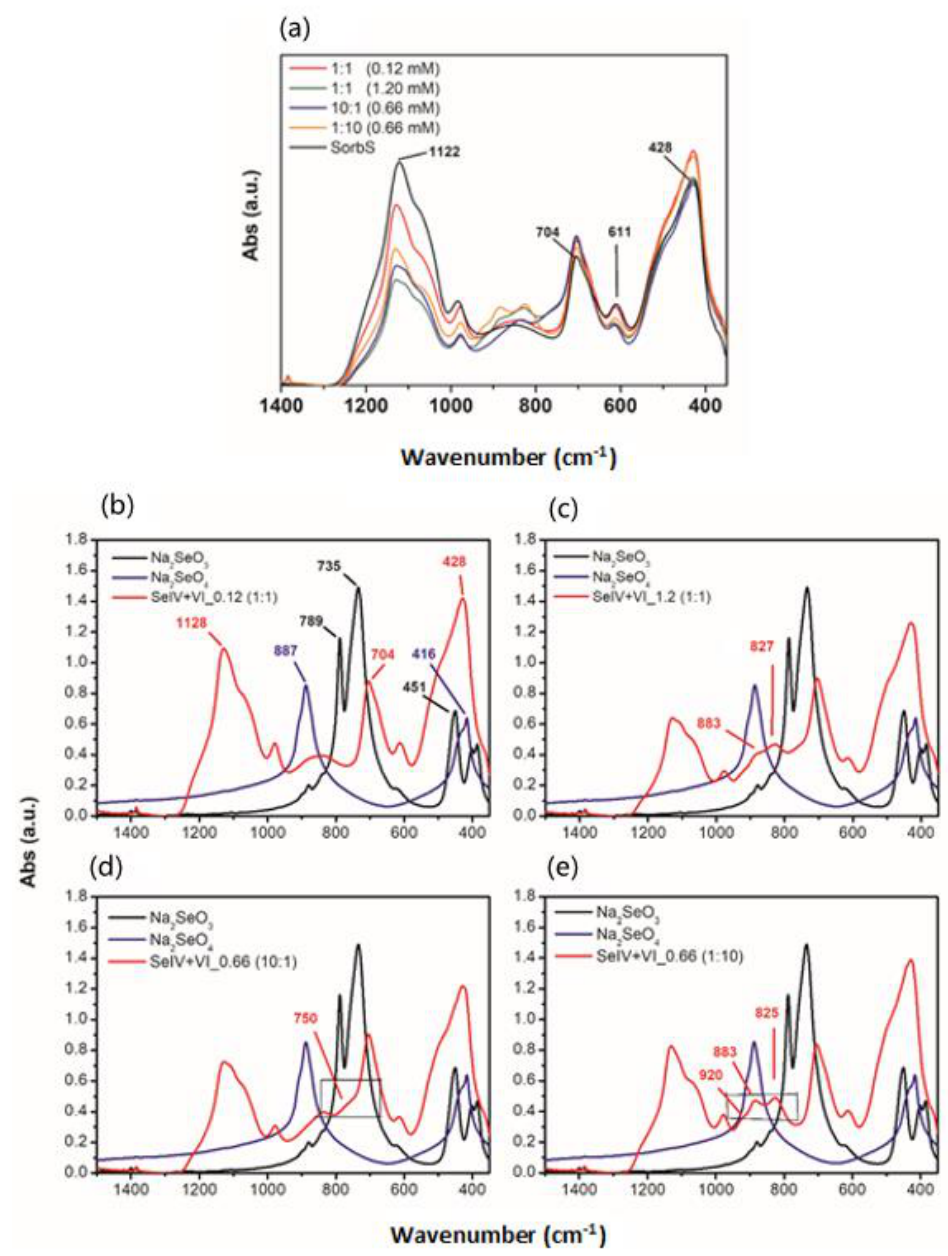
Figure 3. FTIR-spectra of ( a ) adsorbed Se(IV) and Se(VI) onto SorbS in mixed-species experiment at different ratio and SorbS as reference. ( b ) ratio 1:1 (0.12 mM), ( c ) ratio 1:1 (1.2 mM), ( d ) ratio 10:1 (0.66 mM) with dominance of Se(IV) and ( e ) ratio 1:10 (0.66 mM) with dominance of Se(VI). Spectra of Na 2 SeO 3 and Na 2 SeO 4 salts (c = 0.011 mM and c = 0.010 mM, respectively) are plotted as ref- erence.